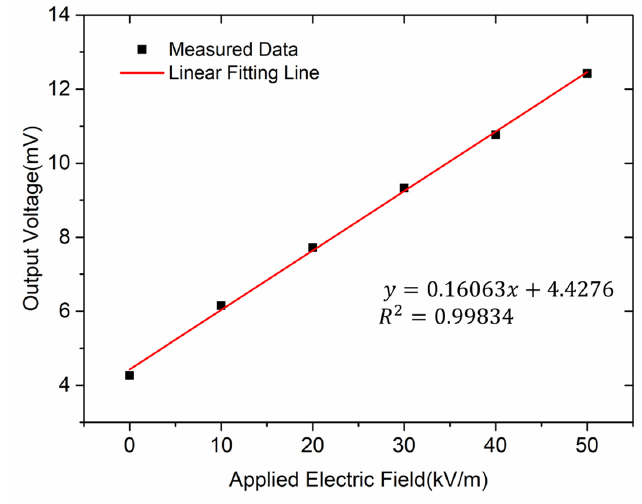
Figure 12. Response of the microsensor versus the applied electric field.